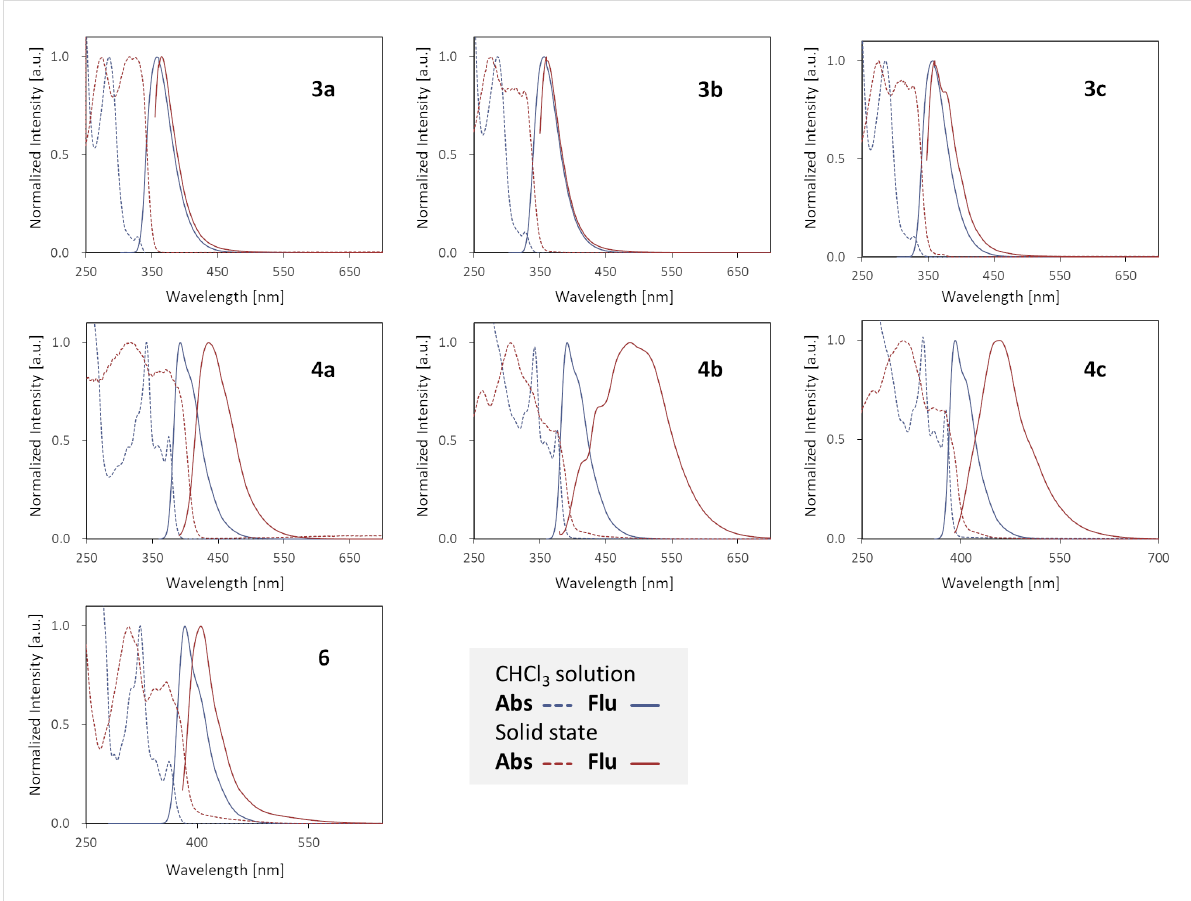
Figure 1: Absorption (dotted line) and fluorescence (solid line) spectra of 3 , 4 , and 6 measured as CHCl 3 solutions (1.0 × 10 − 5 M) and in solid states.